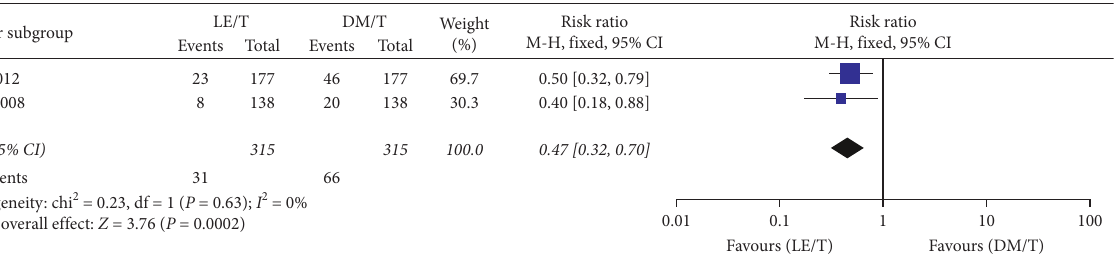
Figure 10: Incidence of elevating intraocular pressure (by 10mmHg or less).